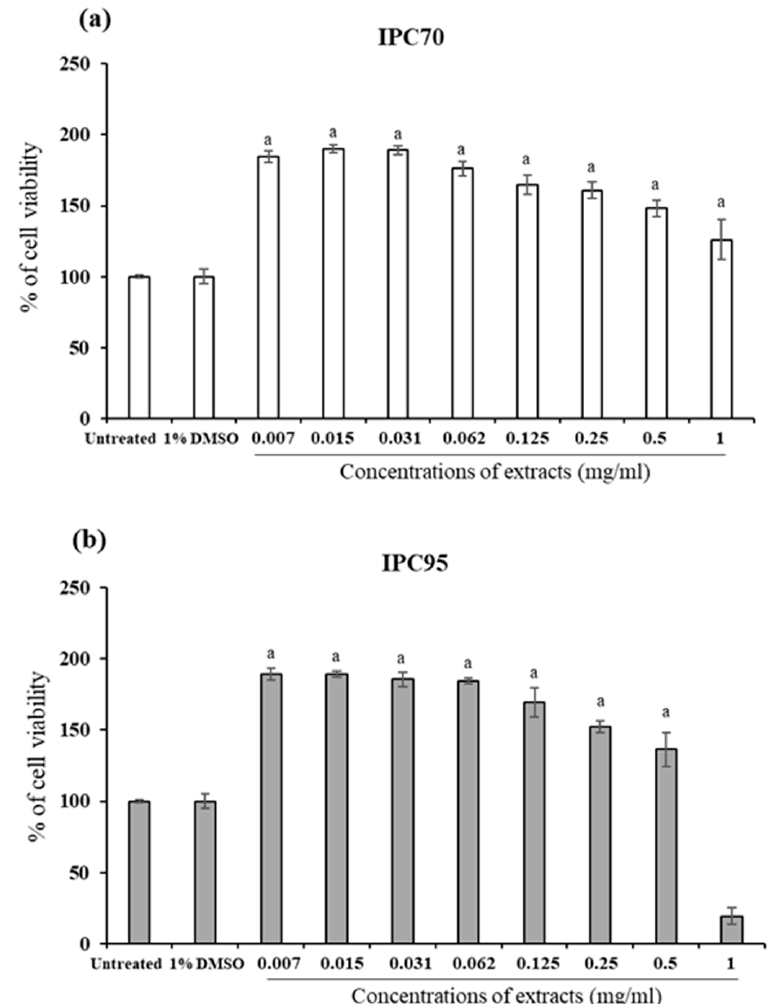
Figure 2. Cell viability of human fibroblasts (CCD-986sk cells) treated with I. pes-caprae extracts. ( a ) IPC70 and ( b ) IPC95 extracts. The percent cell viability is reported as mean ± SD from three independent experiments. The untreated control was set at 100%; ( a ) indicates a significant difference at p < 0.05.